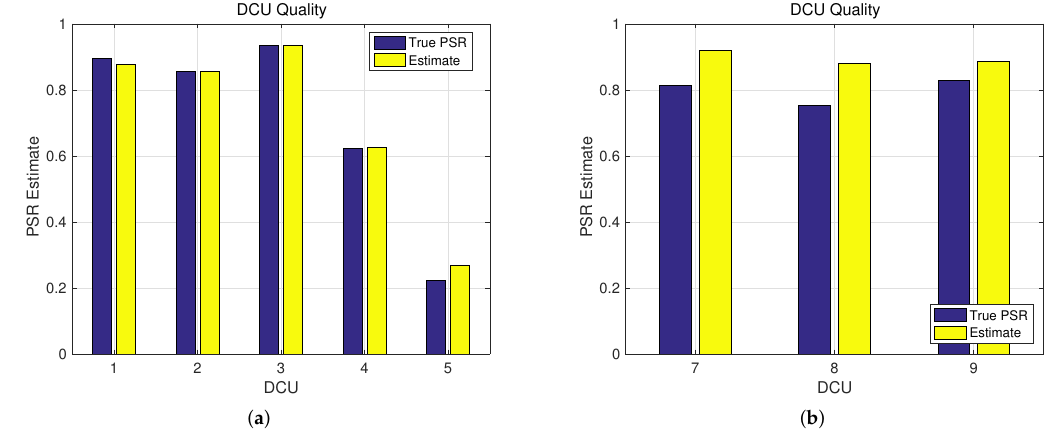
Figure 14. DCU quality (PSR estimate average of the corresponding modems). ( a ) Daejeon TS with 5 DCUs and 50 modems (MSE average: 0.0077). ( b ) Daejeon VS (3 DCUs).